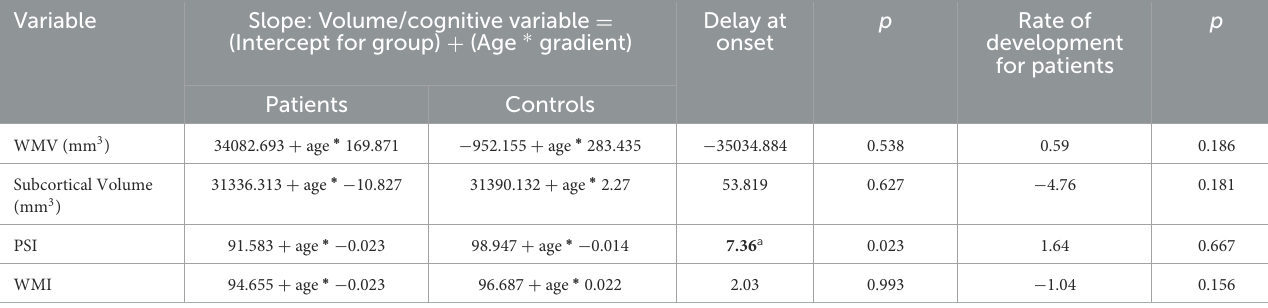
TABLE 9 Developmental trajectories.